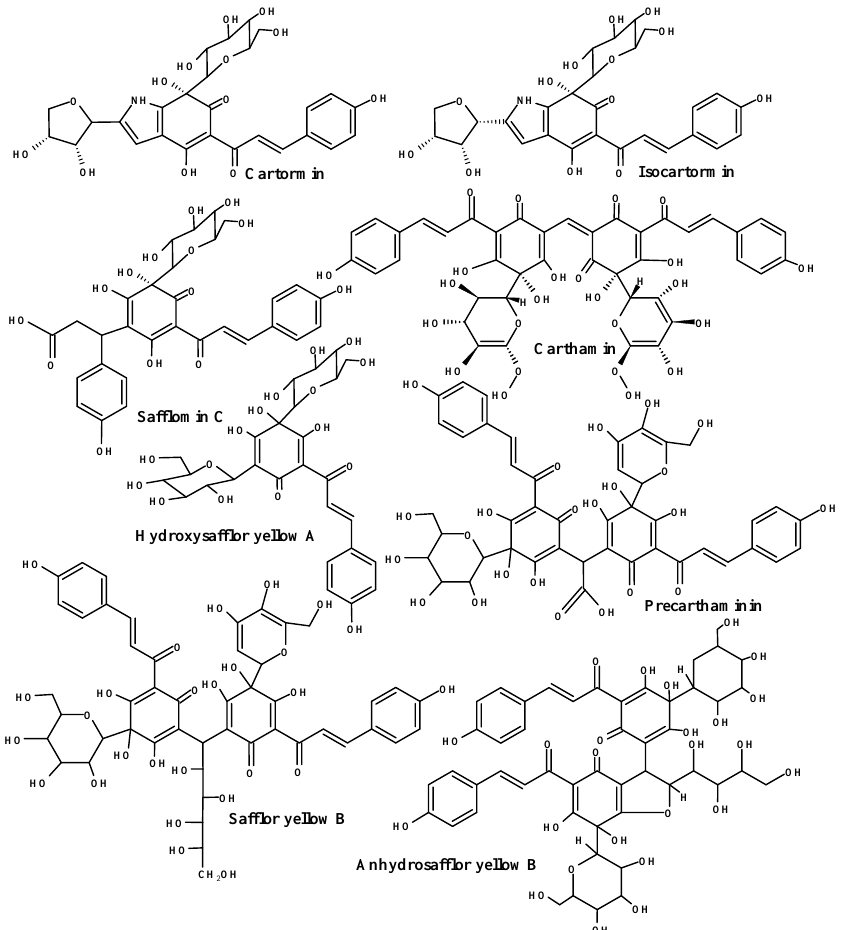
Figure 3. Most prime phytochemicals present in the Carthamus tinctorius (Safflower) extract.